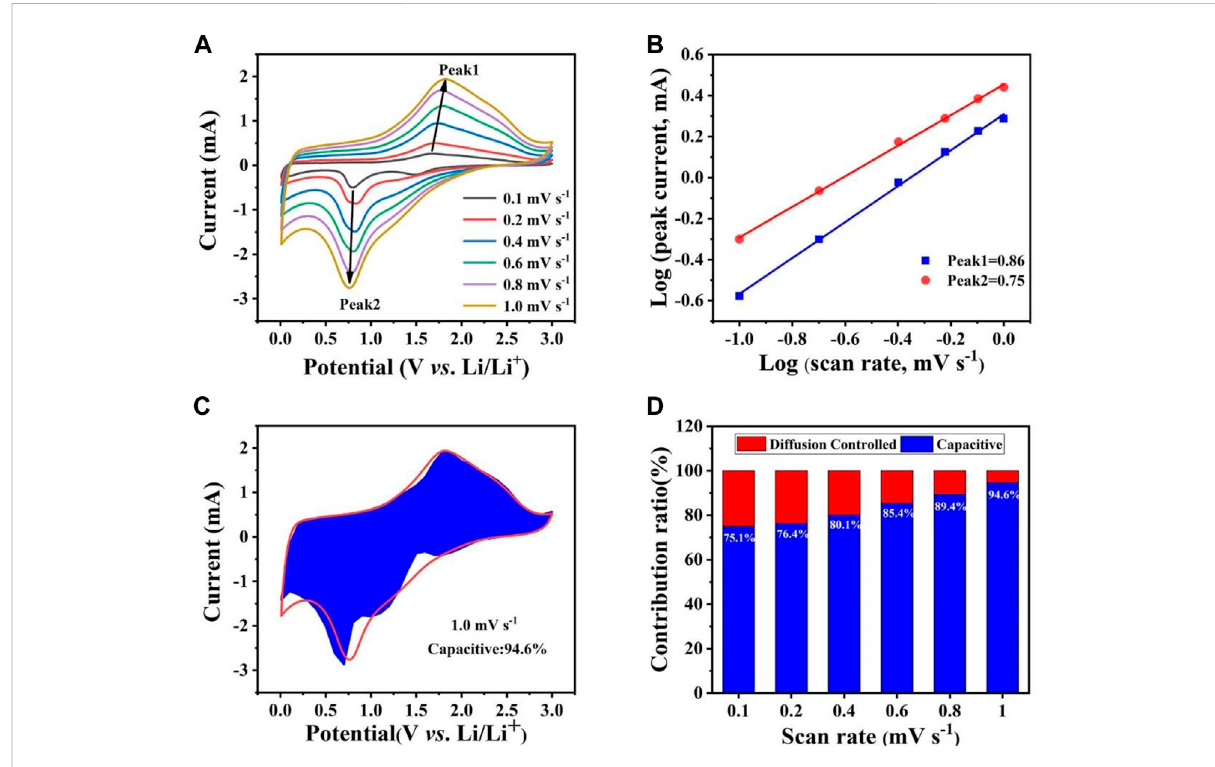
FIGURE 5 (A) CV curves of Co 0.5 Ni 0.5 Fe 2 O 4 at various scan rates ranging from 0.1 mV s − 1 to 1.0 mV s − 1 . (B) the relationship between log(i) and log( v ). (C) The capacitive contribution of